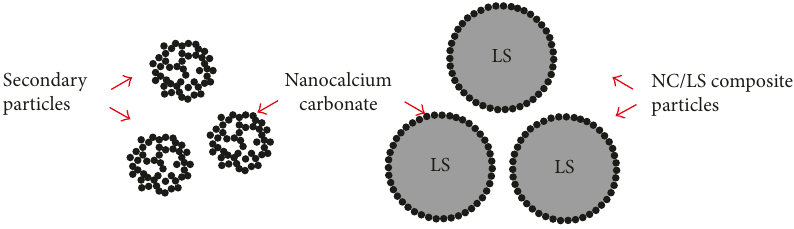
Figure 1: Secondary particles and nanomicron composite particles.